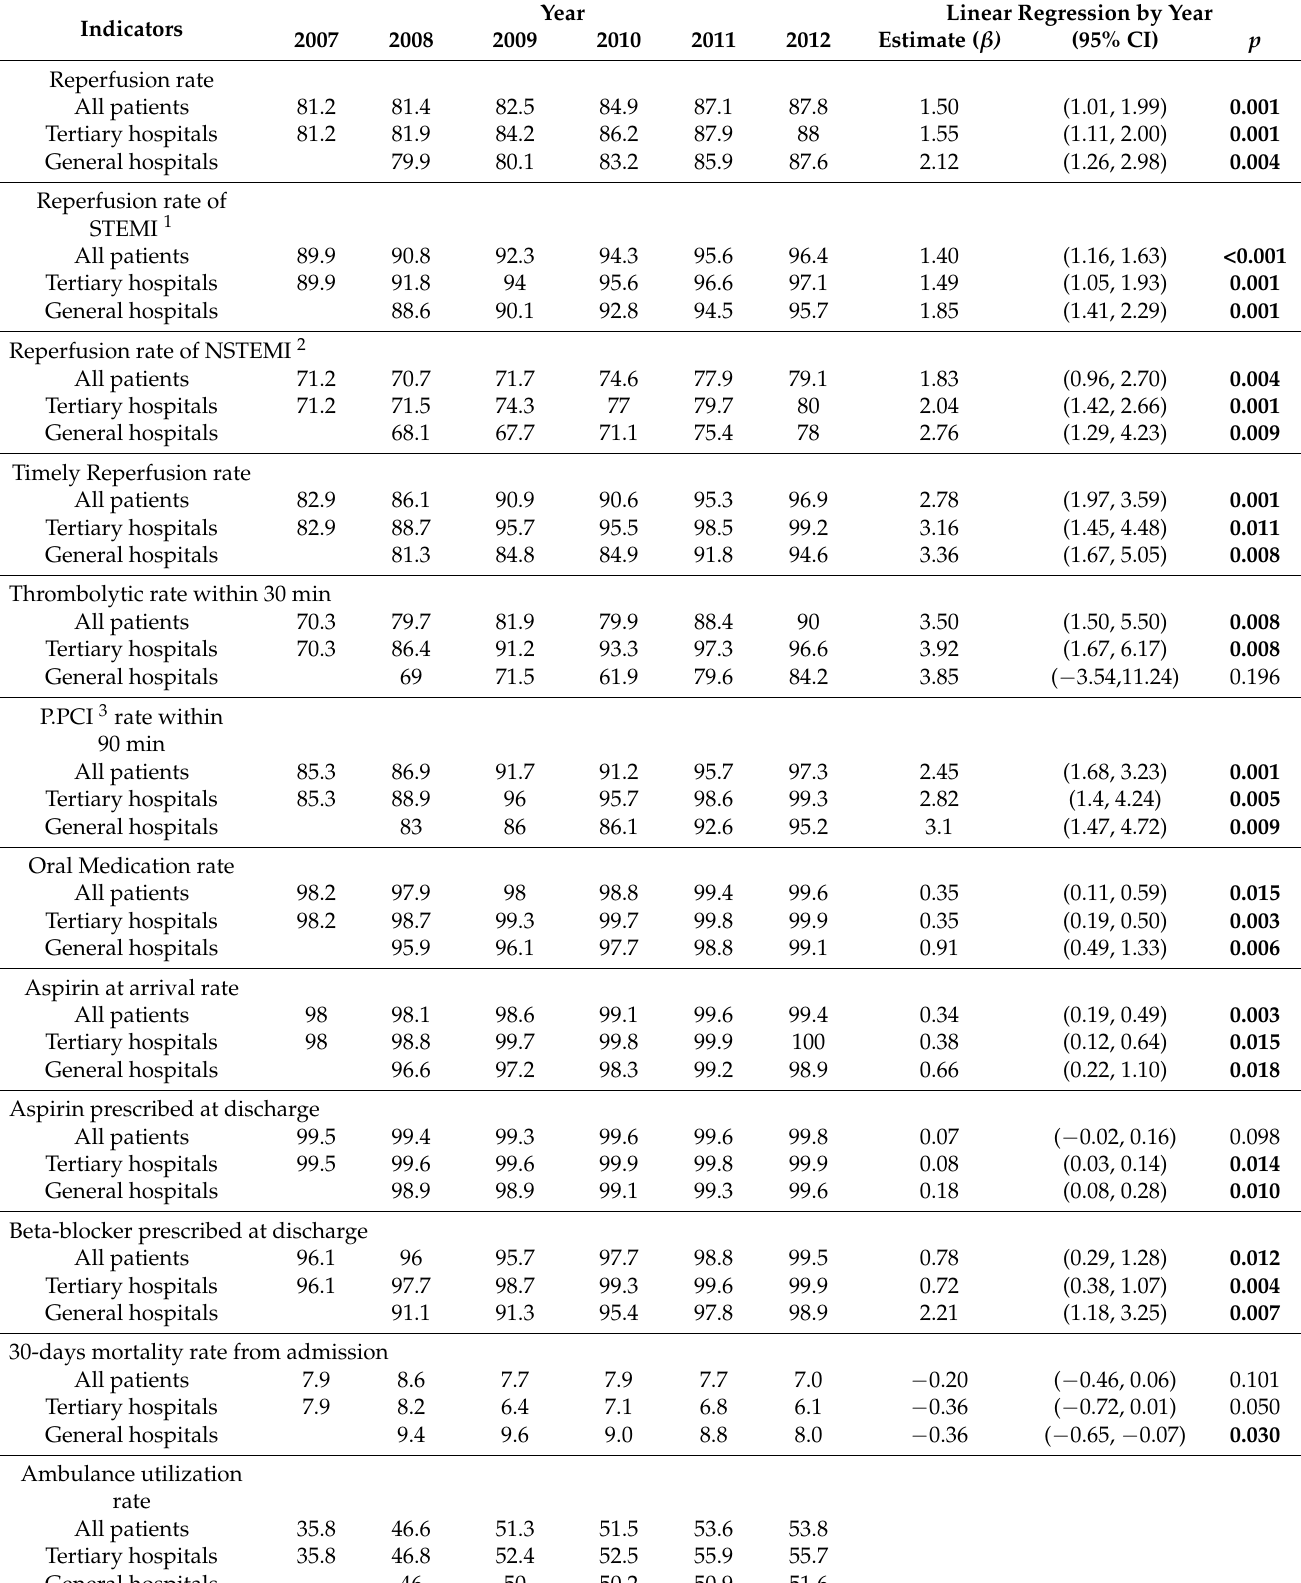
Table 2. Association between year and process and outcome